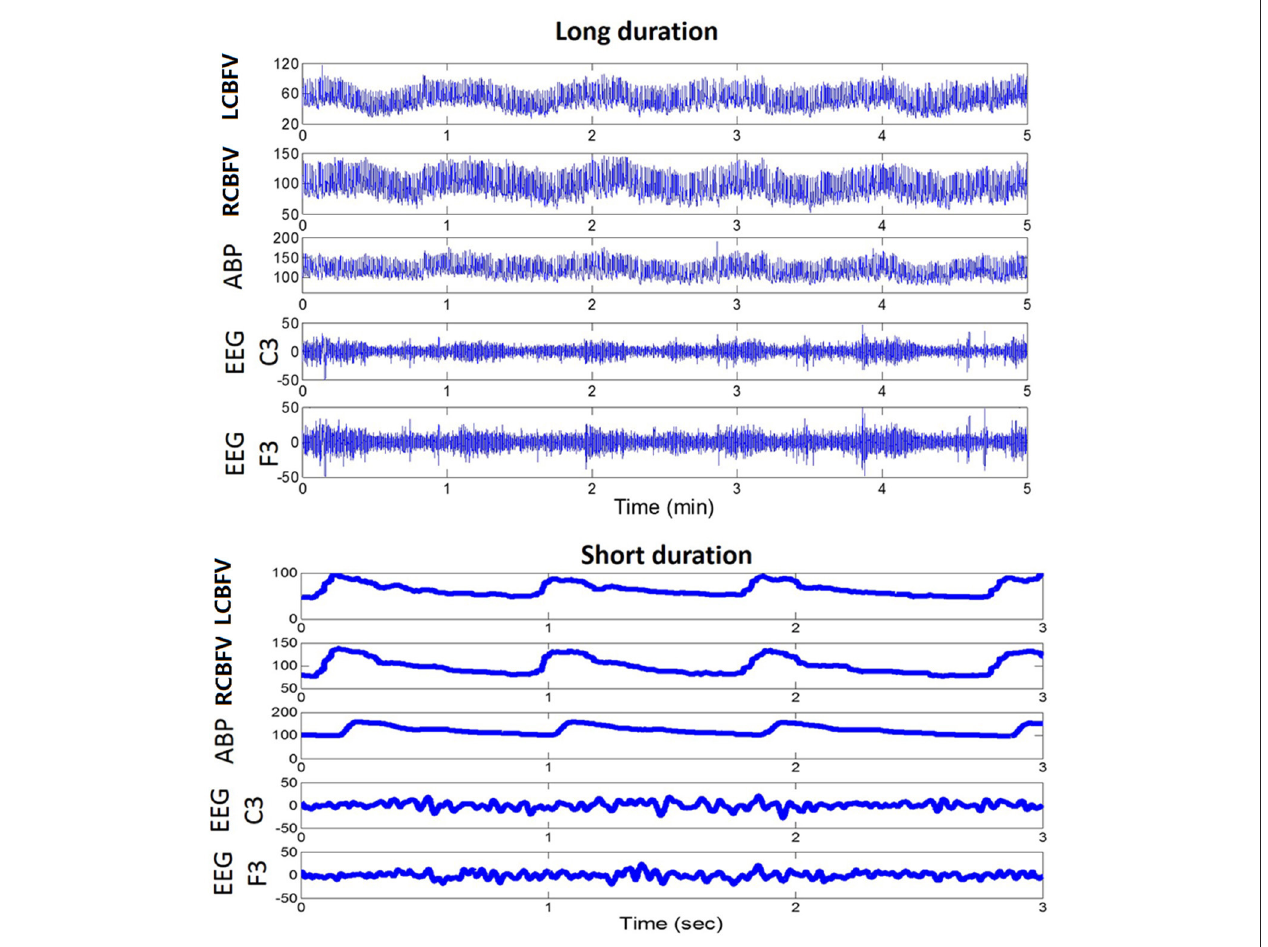
FIGURE 1 | An example of a daily recording of CBFV, ABP, and EEG in a neuro critical care unit. Upper panel: recordings of fast fluctuations (5min). Lower panel: recordings of signal waveforms. CBFV, cerebral blood flow velocity; LCBFV, left CBFV; RCBFV, right CBFV; ABP, arterial blood pressure; EEG, electroencephalography.